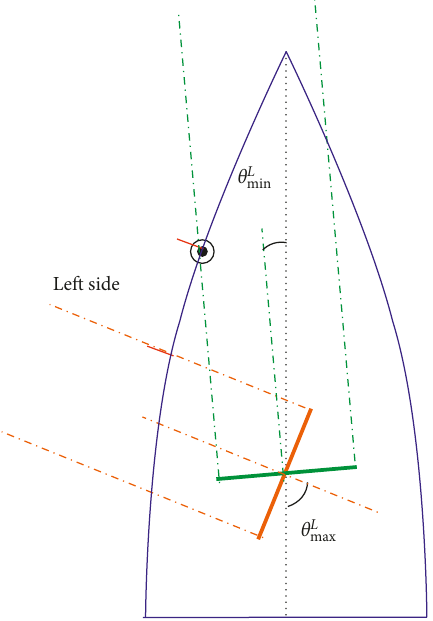
Figure 4: The scan angle range affected by a part of the thickness